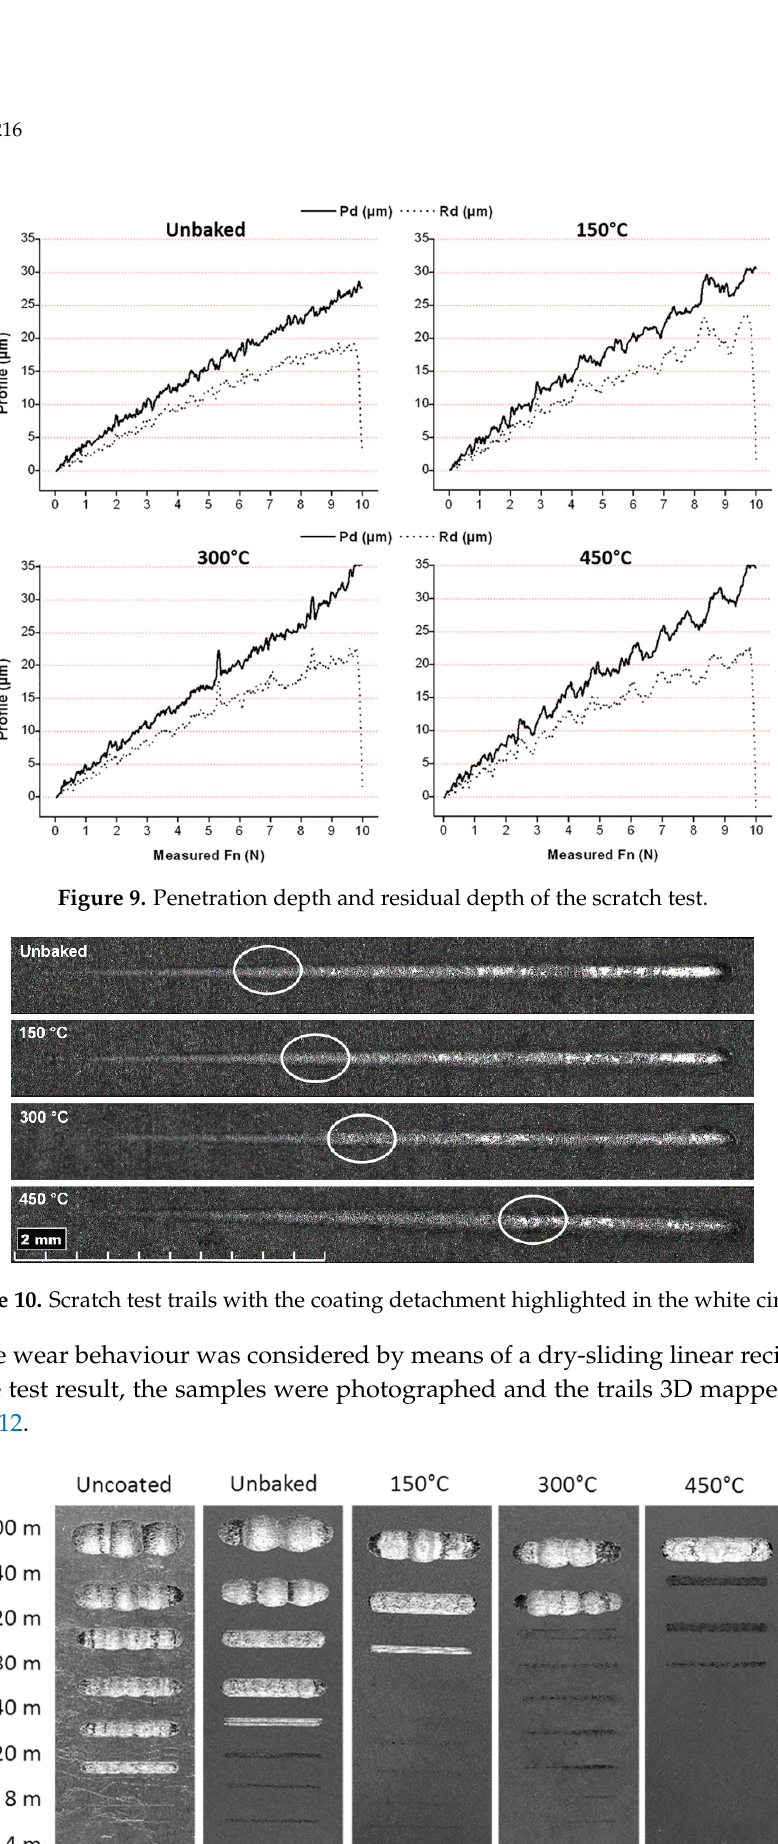
Figure 12. 3D maps of the linear reciprocating trails.